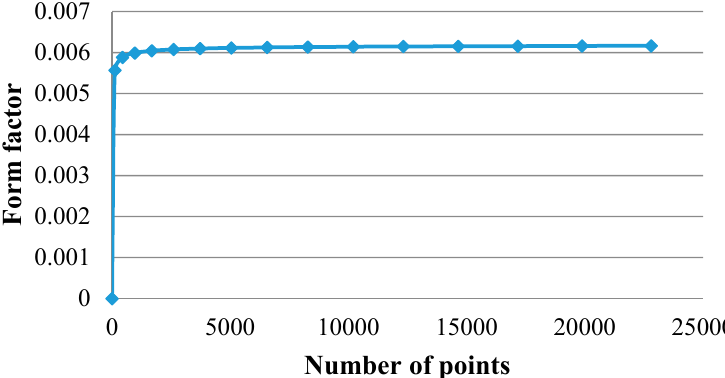
Figure 15. Convergence of the algorithm for the previously studied case.